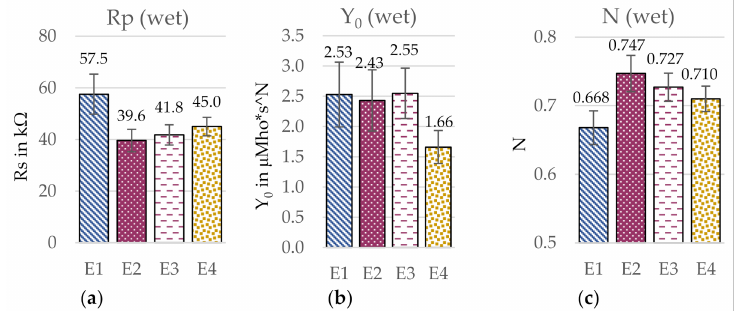
Figure 10. Influence of the electrode construction on the simulated circuit elements. ( a ) Charge trans- fer resistance Rp, ( b ) CPE admittance Y 0 , and ( c ) empirical constant N in wet condition. Estimated error indicated with error bars. Goodness of fit χ 2 (E1) = 8.4; χ 2 (E2) = 7.4; χ 2 (E3) = 5.3; χ 2 (E4) = 4.8.